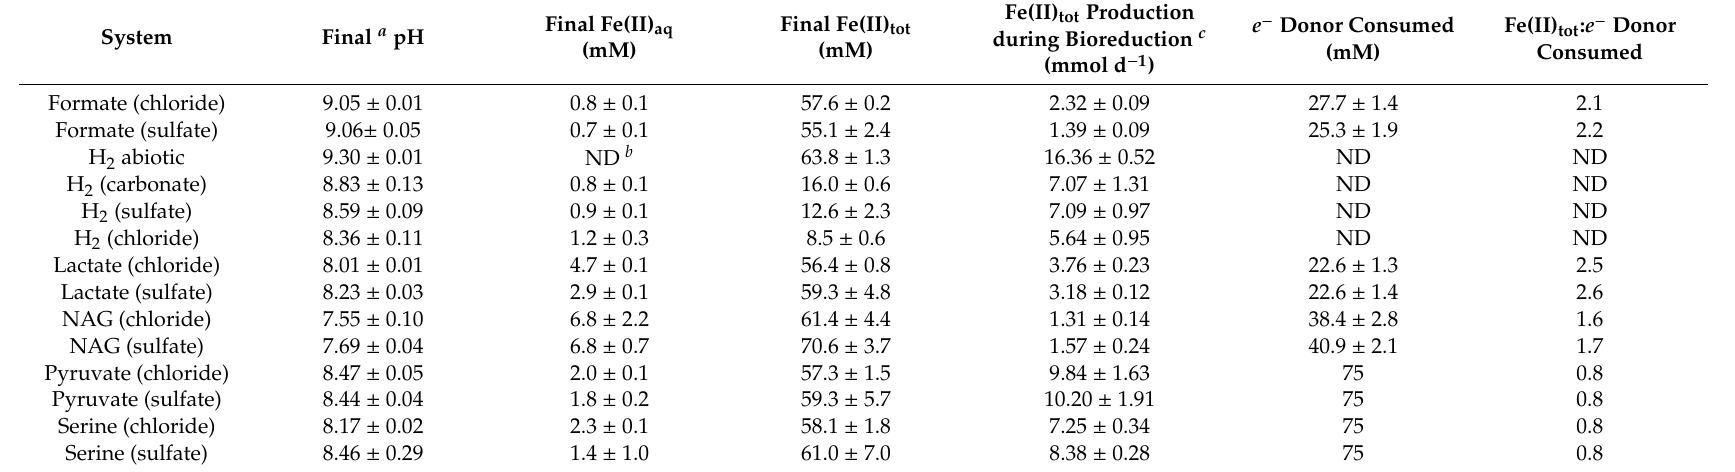
Table 1. Final pH, Fe(II), and acetate concentrations, maximum Fe(II) production rates, and e − donor consumption